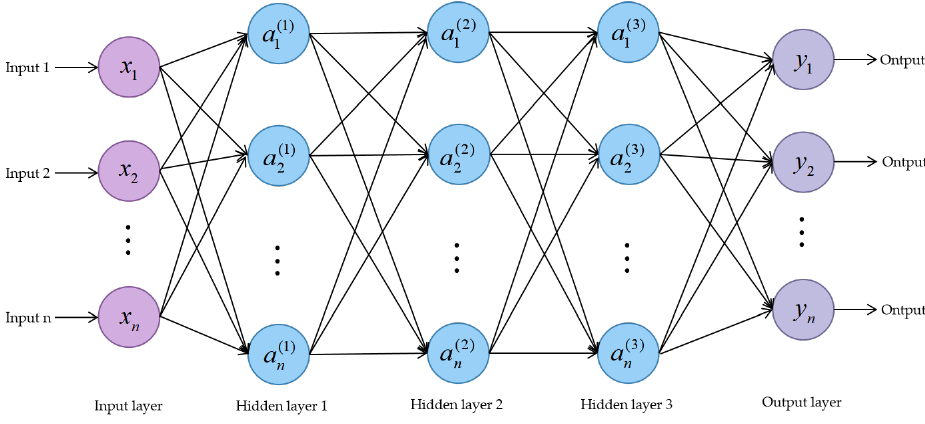
Figure 3. The schematic diagram of a five-layer neural network.